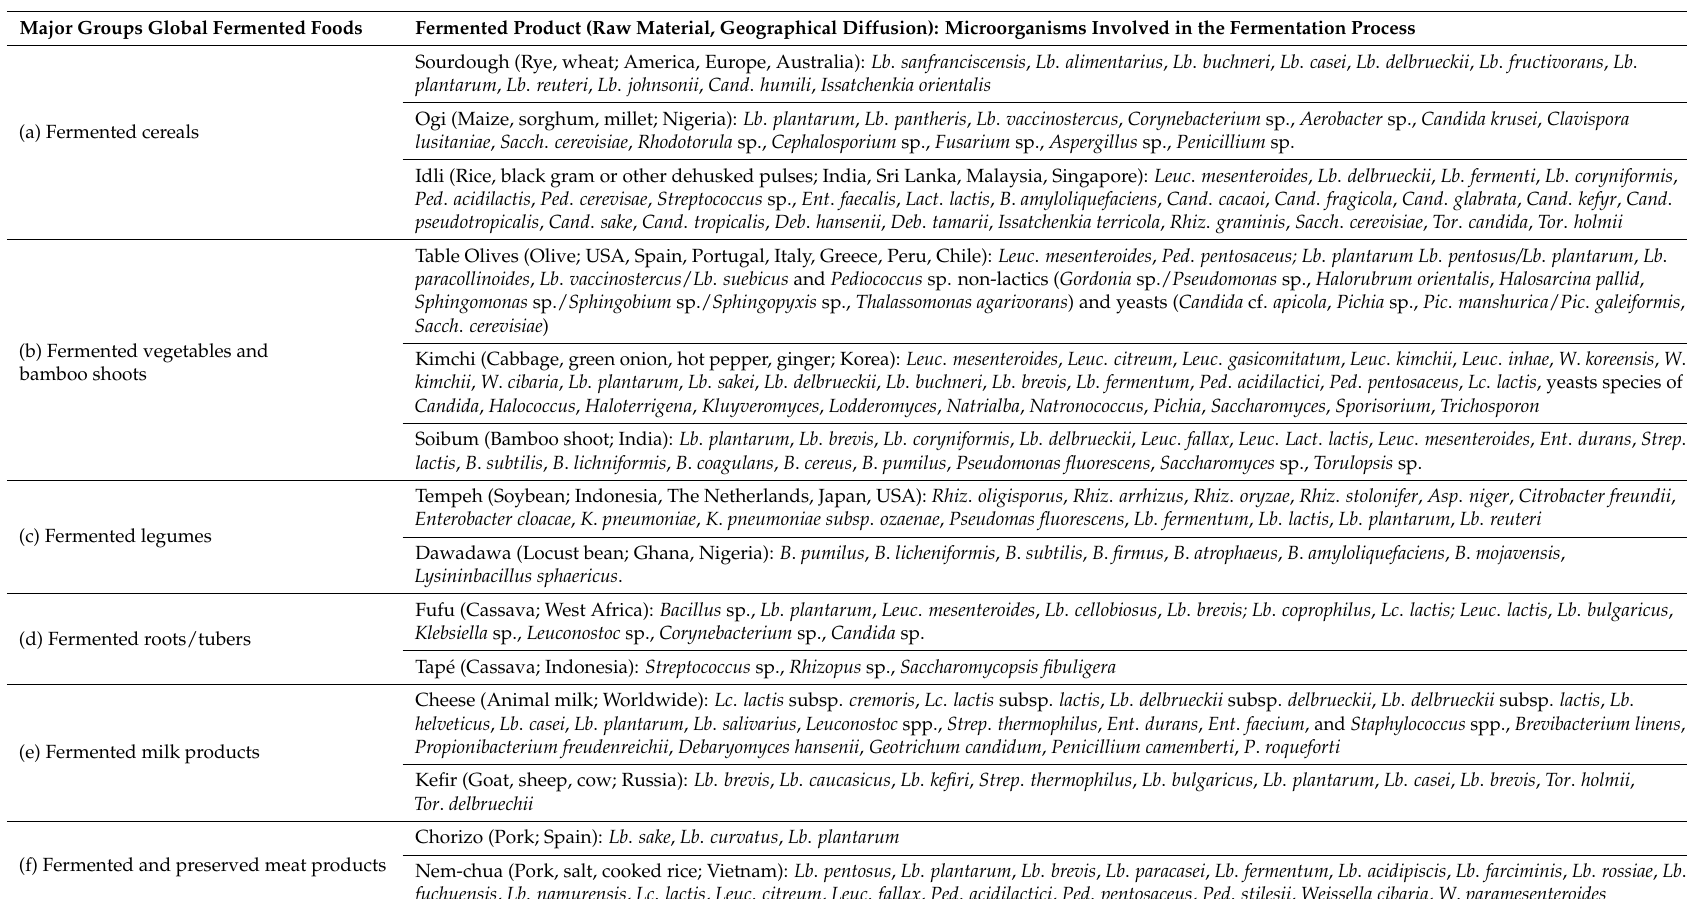
Table 1. Non-exhaustive list of fermented foods belonging to the main categories of global fermented foods. Information reported in accordance to Tamang et al. [16] (to Petruzzi et al. [20] for wine and Greppi et al. [21] for ogi and for tchoukoutou). Major Groups Global Fermented